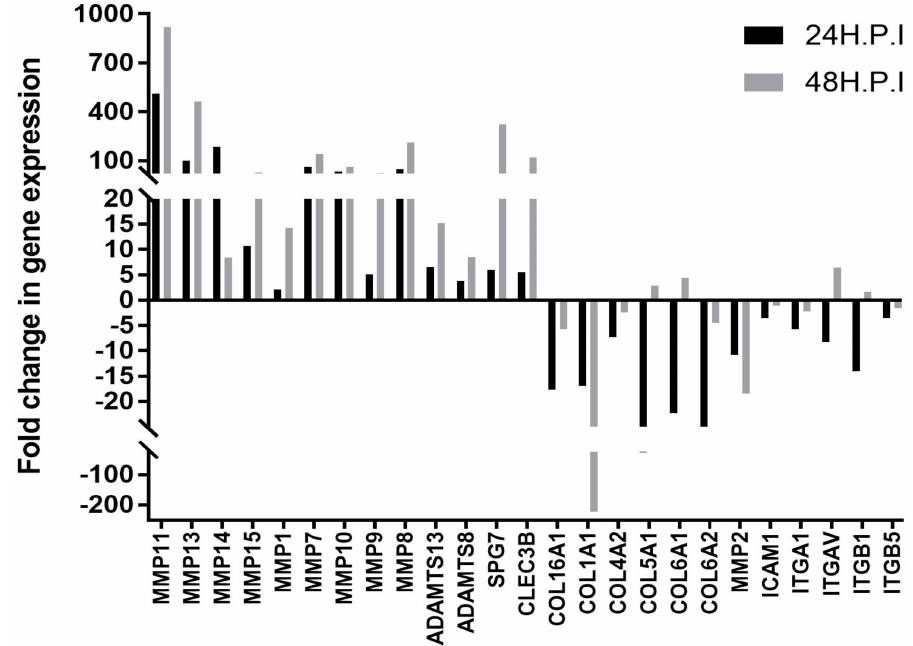
Figure 2. Modulation of extracellular matrix genes by MAYV in primary human chondrocytes. Human chondrocytes were infected with MAYV at MOI 1. The modulation of extracellular matrix and adhesion molecules gene expression was quantified by RT 2 Profiler PCR arrays at 6 and 24 h post-infection. The graph represents the most important expressed genes. Gene modulation was considered statistically significant at a 95% confidence level ( p < 0.05). RT 2 profiler real-time PCR (RT-PCR) array data analysis software (version 3.5) was used for statistical analysis. Table 1. Modulation of antiviral genes by Mayaro virus in primary human chondrocytes. Fold Change in Gene Expression at Indicated Time Postinfection a